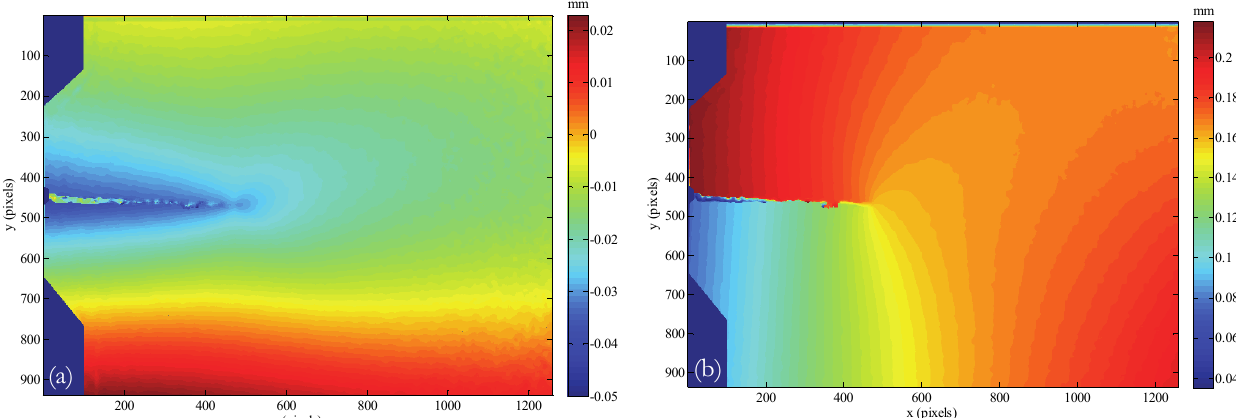
Figure 2: Horizontal (a) and vertical (b) displacement fields measured with DIC for a crack length of 9.40 mm at a load level of 750